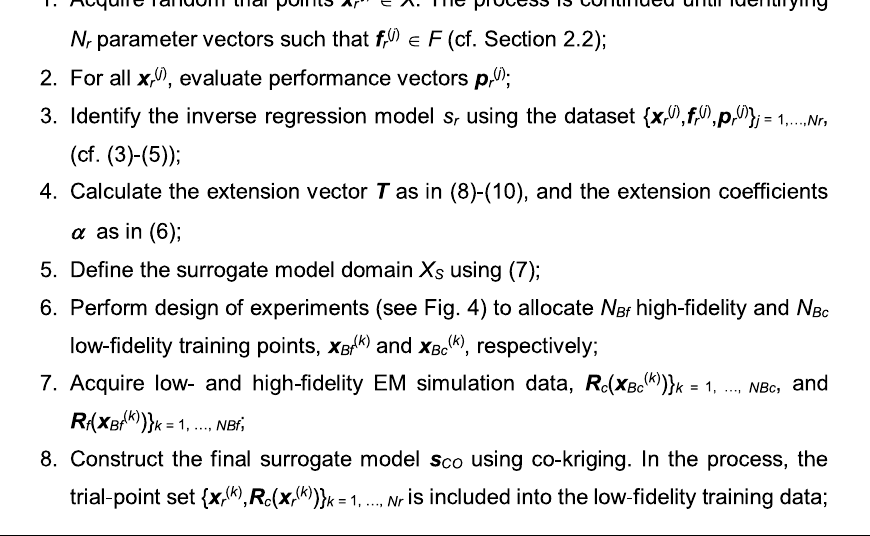
Figure 6. The workflow of the proposed antenna modeling procedure with variable-resolution EM simulations.